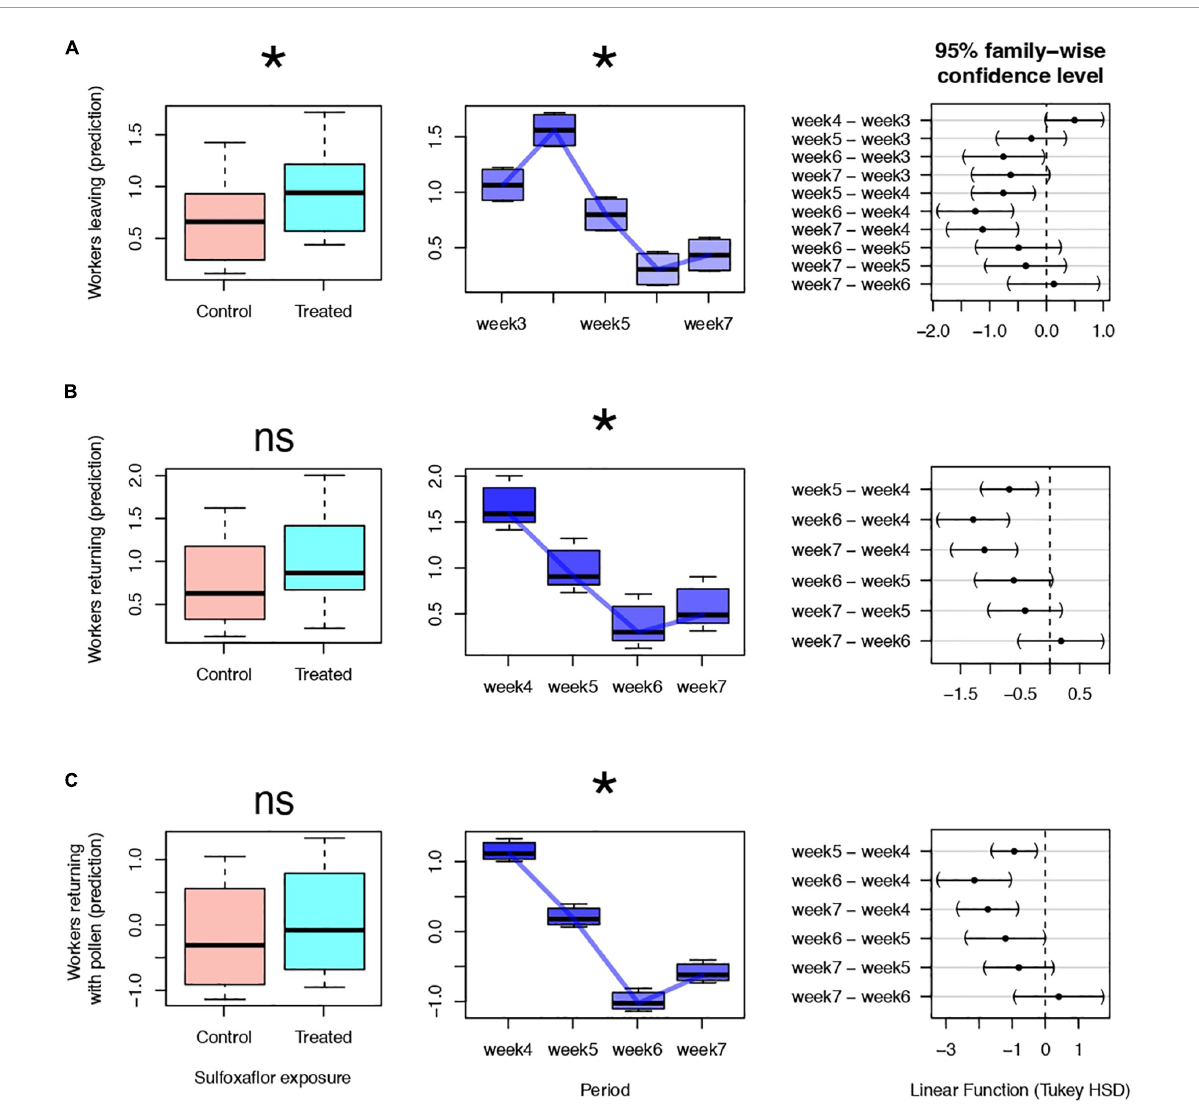
FIGURE1 Flight activities of bumble bees measured in terms of individuals leaving (A) , returning (B) , and returning with pollen (C) to the nest (predictions from Generalized Linear Mixed Model, with Poisson distribution family, in which treatment and period of observations (weeks) were fixed and nest identity random factors). The Left and middle plots show the effects of treatment and weeks, respectively. The plots on the right show pairwise comparison (Tukey HSD test) between weeks (intervals apart from zero -dashed line- indicate significant differences). *Significant ( p < 0.05) and ns: non-significant